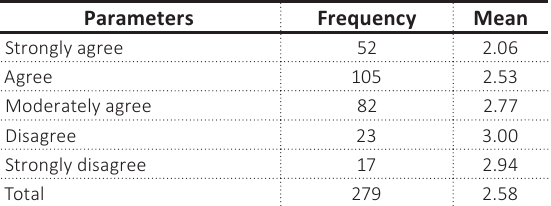
Table 8. Audit effectiveness and tax compliance – one-way ANOVA mean extracts